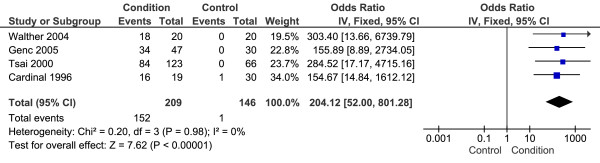
Forest plot of studies reporting hypoechogenicity of the proximal plantar fascia.